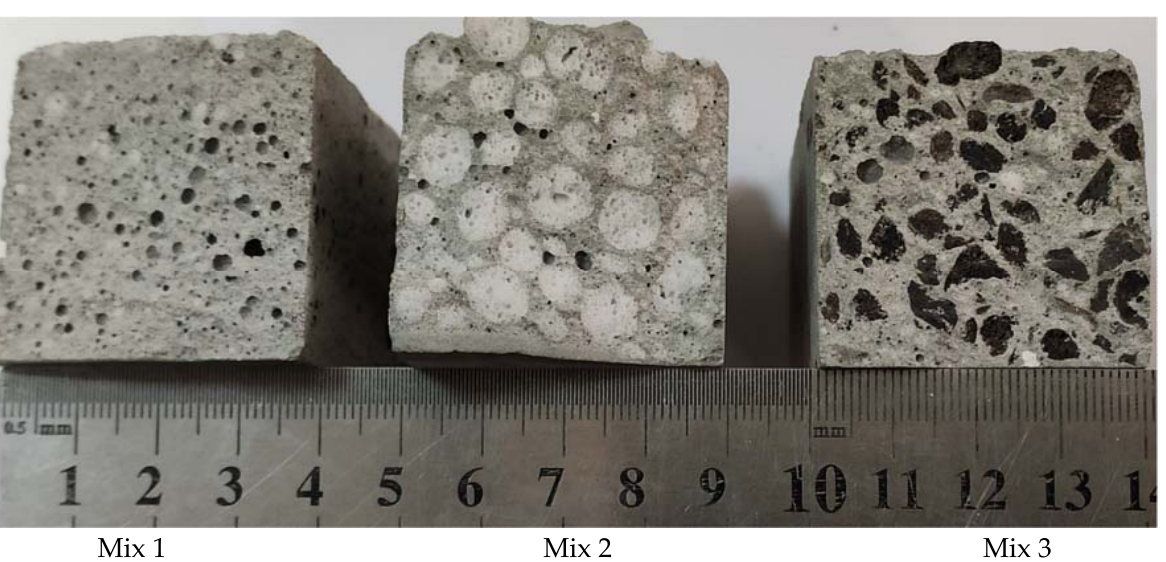
Figure 5. The porosity of lightweight aggregate shotcrete samples. P—total porosity; oP—open porosity; cP—closed porosity.